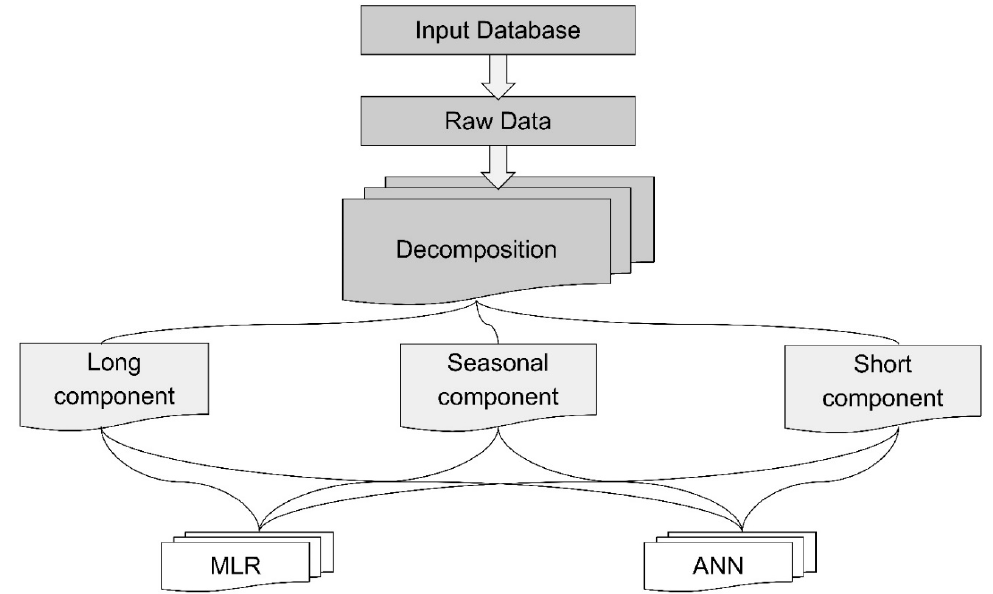
Figure 4. The flowchart shows the hybrid model that consists of the data processing and the integration of the decomposition into the multiple linear regression (MLR) or artificial neural network (ANN) application.